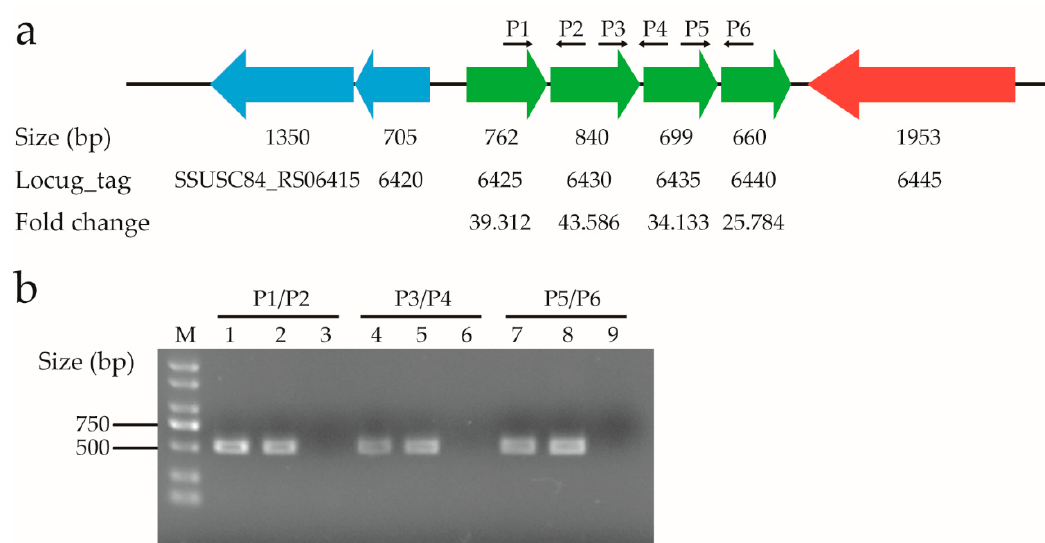
Figure 9. Expression of the genes in an amino acid ABC transporter operon after treatment with ferrous iron. ( a ) Genomic context and expression levels of the genes in the operon. The SSUSC84_RS06425 and SSUSC84_RS06430 genes encode an amino acid ABC transporter ATP-binding protein and glutamine ABC transporter substrate-binding protein, respectively, while the SSUSC84_RS06435 and SSUSC84_RS06440 genes both encode the amino acid ABC transporter permease. The SSUSC84_RS06415 ( vicK ) and SSUSC84_RS06420 ( vicR ) genes encode the VicRK two- component regulatory system, and the SSUSC84_RS06445 gene encodes threonine-tRNA ligase. The